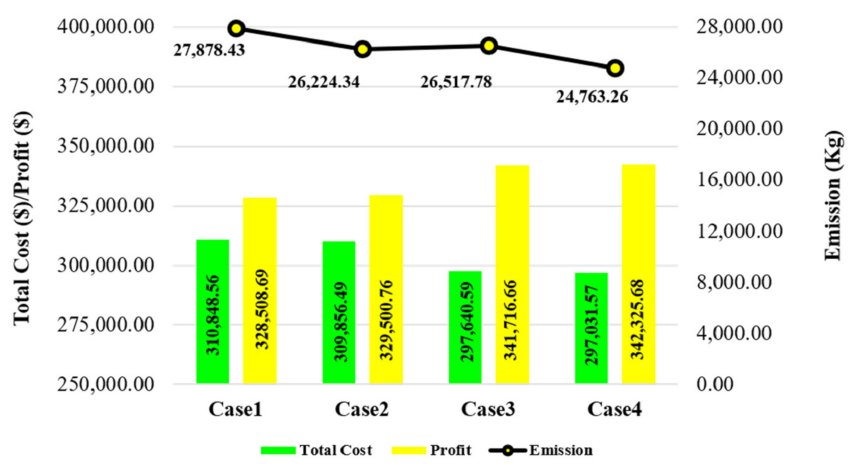
Figure 13. Comparison of cost, profit and emission under the scenario of emission